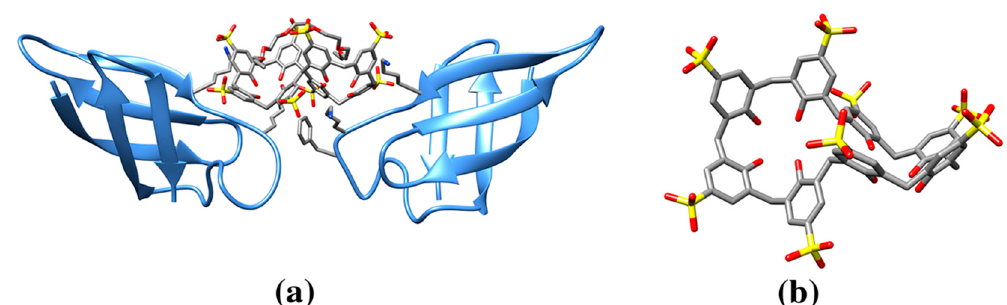
Figure 5. ( a ) Ribbon drawing of fungal protein PAF in complex with sulfonatocalix[8]arene ( sclx 8 ) (pdb entry 6haj). The structure shows a calixarene molecule sandwiched between two protein molecules with a conformation accommodating the nanomolecule binding through several charged and hydrophobic residues. A PEG-molecule is hosted in the cavity of sclx 8 ( b ) Sulfonatocalix[8]arene molecule (cif code EVB, S yellow).